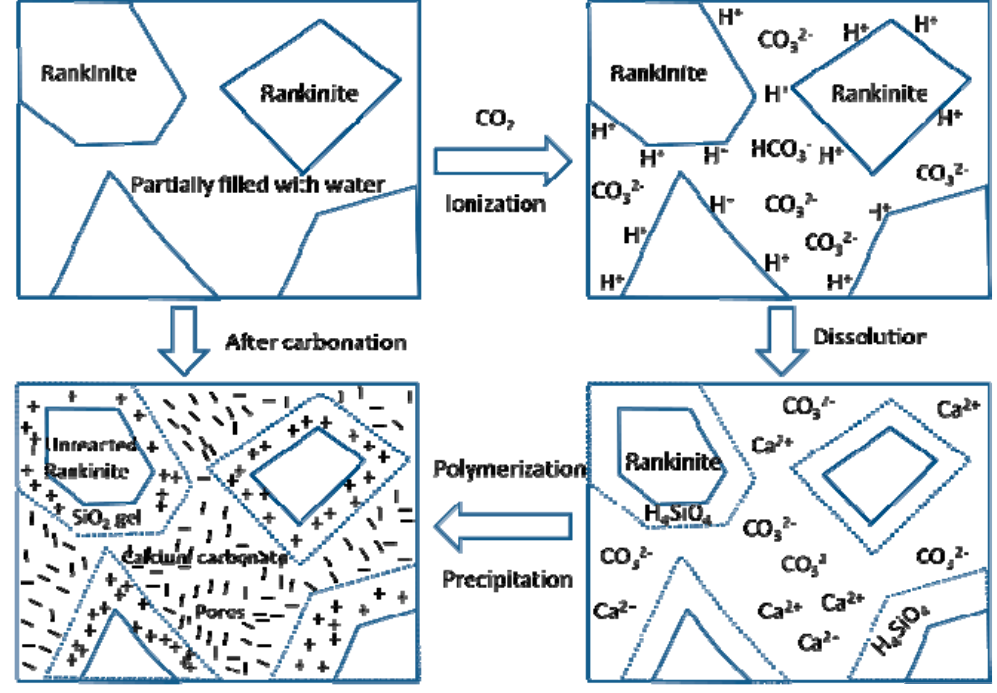
Figure 7. The reaction mechanism that occurred during the carbonation of C 3 S 2.